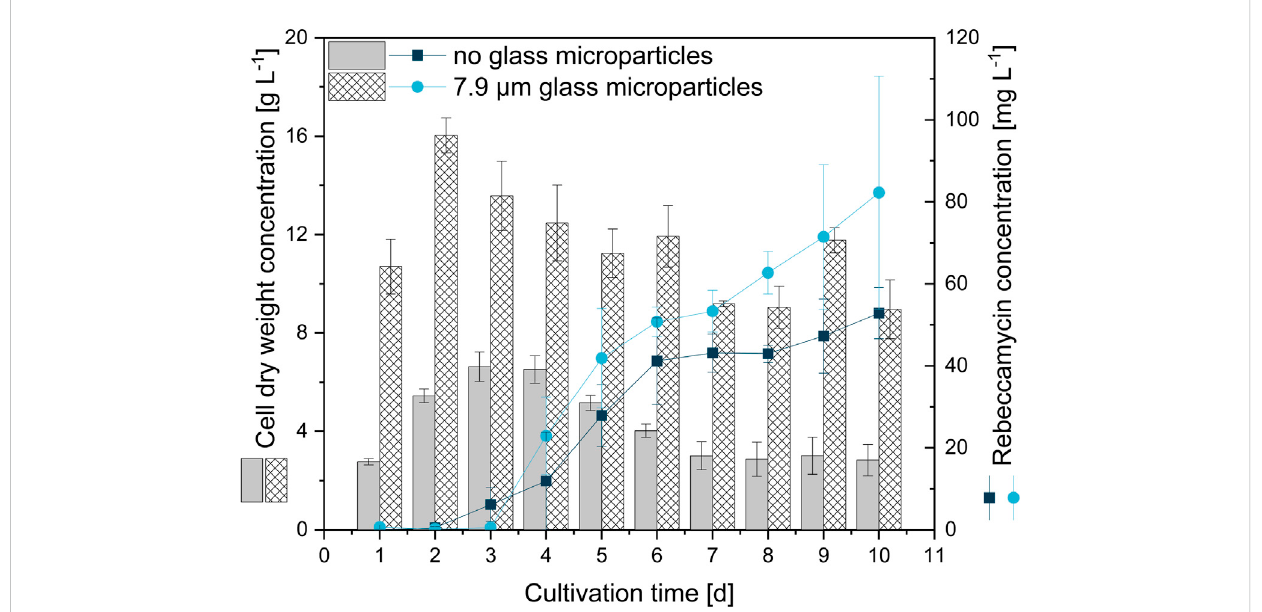
FIGURE 6 Cell dry weight concentration and rebeccamycin concentration for 10-day L. aerocolonigenes cultivation without glass microparticle addition (control, grey, and dark blue circles) compared to MPEC with glass microparticles (10 g · L − 1 , x 50 = 7.9 µm white patterned, light blue